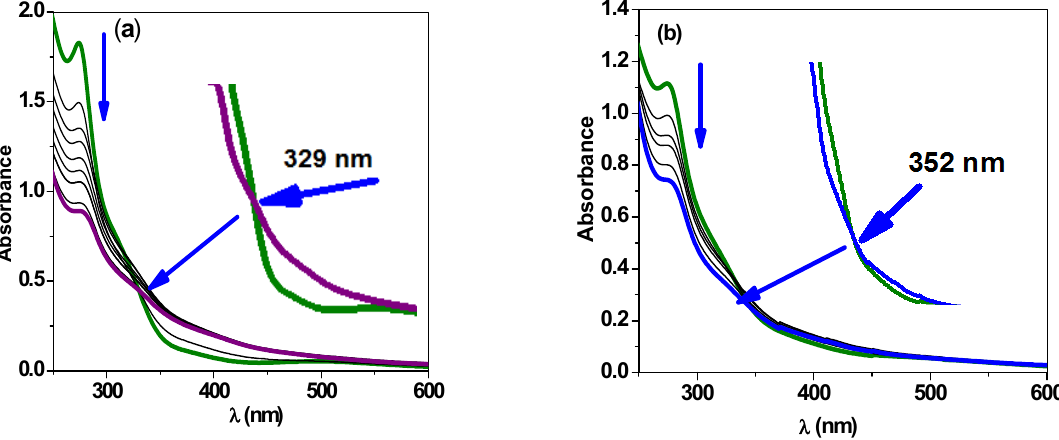
Figure 8. UV–vis absorption spectral changes recorded during the reaction of different concentrations of DNA with ( a ) [RuNOTSP] + ; ( b ) TSP-H 2 at 274 nm.